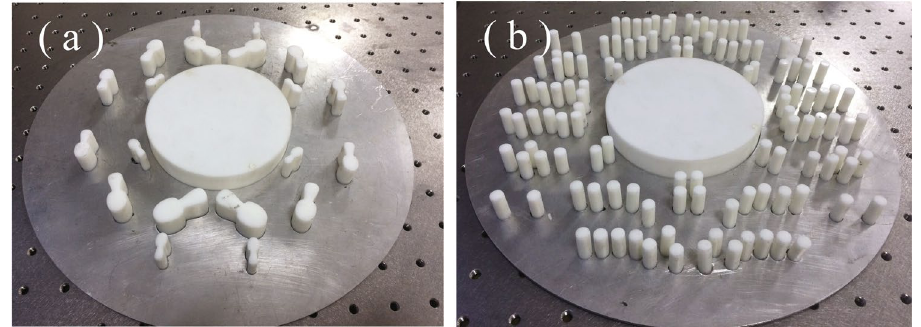
Figure 4. Photographs of the structures fabricated with a 3D printer in ABS plastic. ( a ) Object plus cloak made of 20 Bézier cylindrical scatterers; ( b ) object plus cloak made of 120 cylindrical scatterers with circular cross- section.